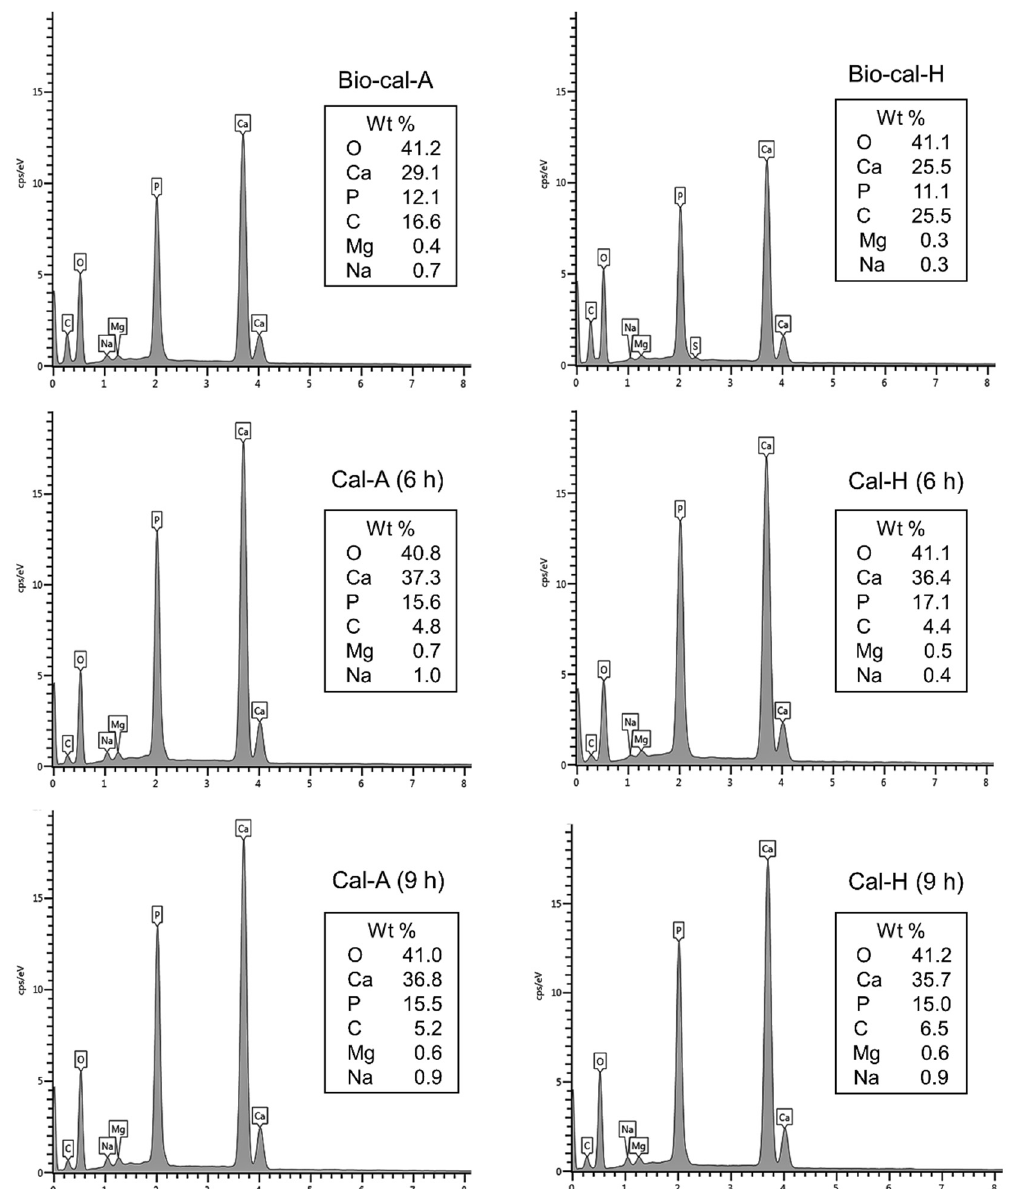
Figure 5. Elemental profile of bio-calcium and calcined powders from salmon bones as analyzed by SEM-EDX.